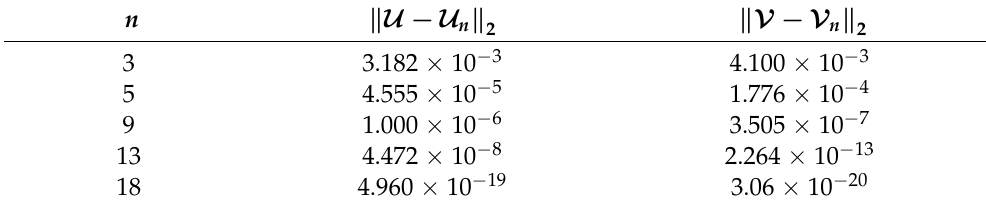
Table 1. Example